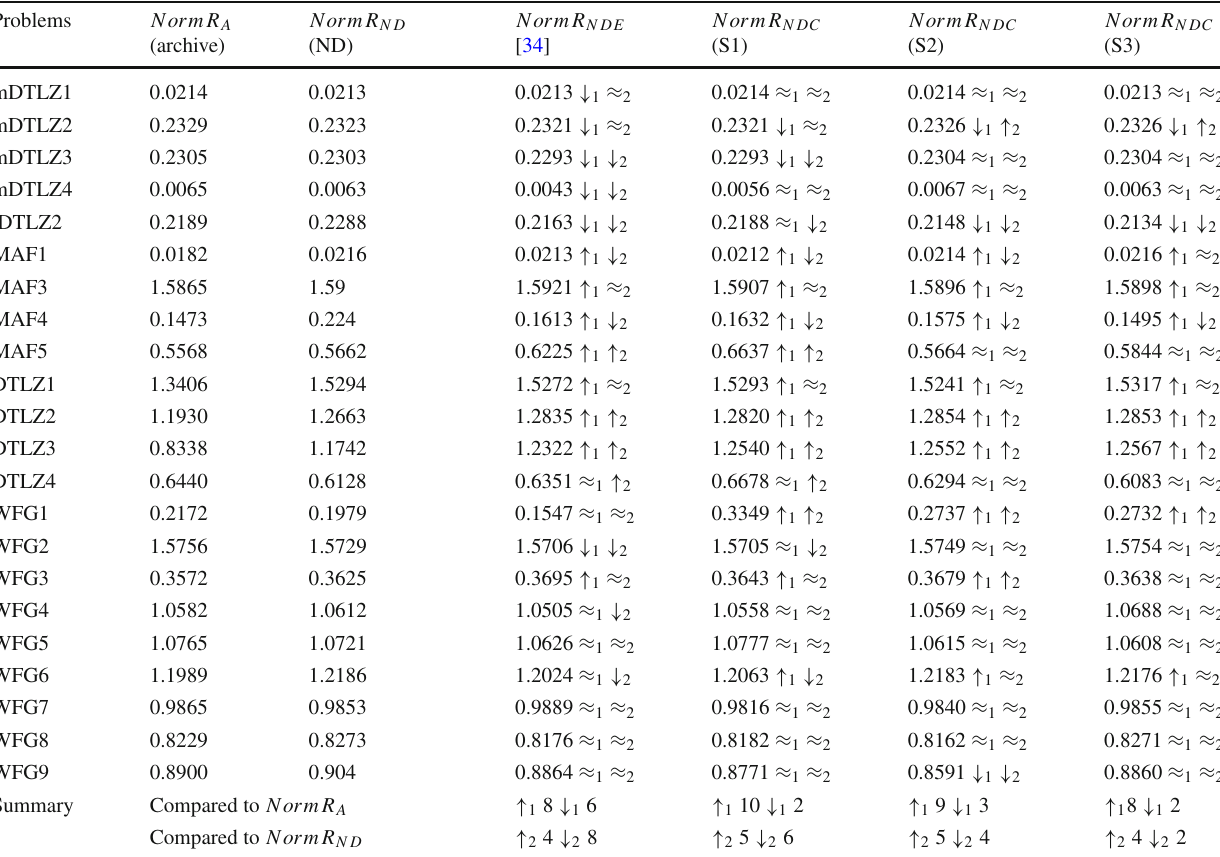
Table 4 Median HV performance in test problems with 5 objective across 29 independent runs